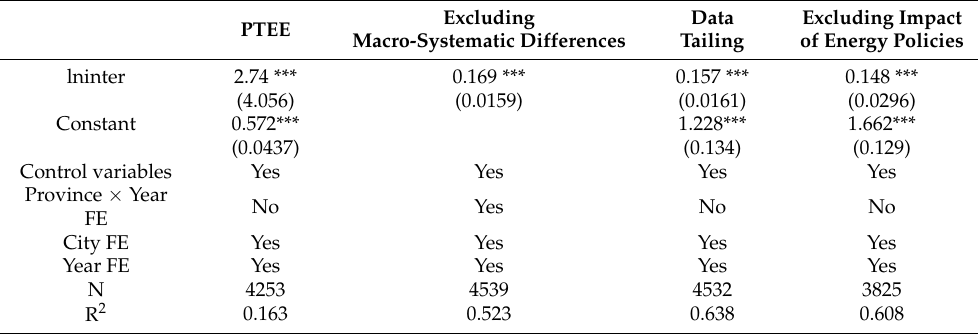
Table 5. Robustness